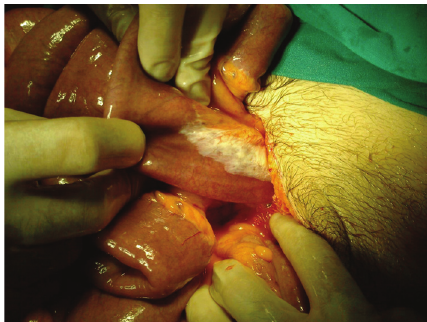
Figure 2: A light mononuclear inflammation was observed to have infiltrated the cells of the muscle and serous layer in the submucosal appendix tissue (x40